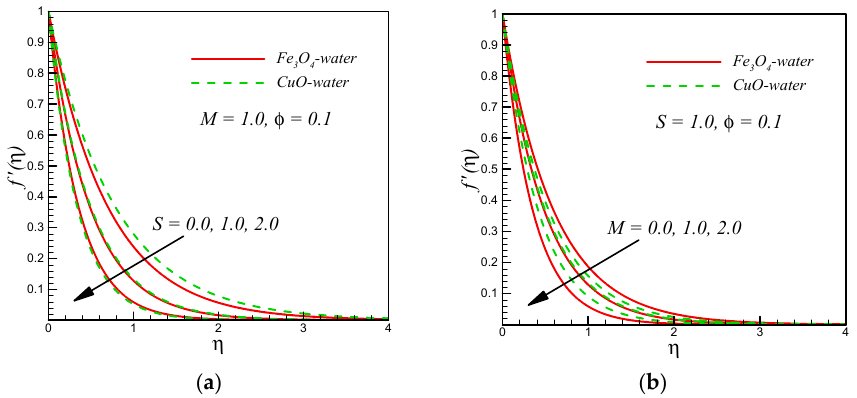
Figure 2. Variation of the velocity profile ƒ (cid:4593) (𝜂) with ( a ) 𝑆 and ( b ) 𝑀 .